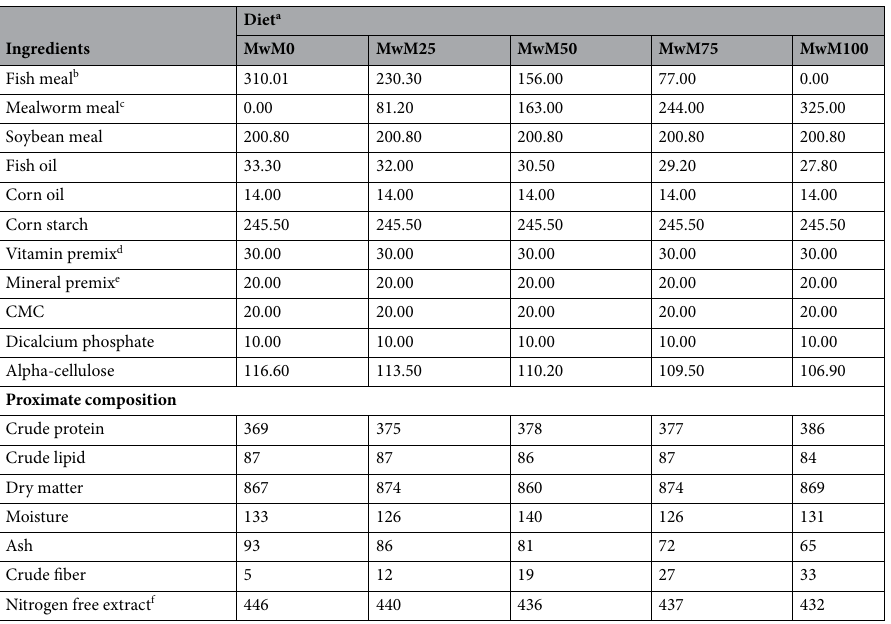
Table 1. Ingredients and proximate composition (g/kg dry diet) of experimental diets with increasing substitution level of fishmeal with mealworm meal. CMC carboxymethyl cellulose. a MwM denotes a mealworm meal. The number following the letters denotes the % of MwM added, for each diet. b Danish fishmeal purchased from Cargill, Penang, Malaysia (dry matter: 86.9%; crude protein: 79.0%; crude lipid: 8.6%). c Fed with C. necator cells as finishing diet (dry matter: 94.2%; crude protein: 75.47%; crude lipid: 9.9%; ash: 6.8%; fiber: 11.0%). d Vitamin premix (g kg −1 of premix): inositol, 5; ascorbic acid, 45; choline chloride, 75; niacin, 4.5; pyridoxine HCl, 1; riboflavin, 1; thiamin mononitrate, 0.92; cholecalciferol, 0.083; calcium d-panthothenate, 3; retinyl acetate, 0.6; dl-α-tocopheryl acetate (500 IU g −1 ), 8; menadione sodium bisulfide, 1.67; d-biotin, 0.02; folic acid, 0.09; cellulose, 845.11; vitamin B 12 , 0.00135. e Mineral premix (g kg −1 of premix): calcium